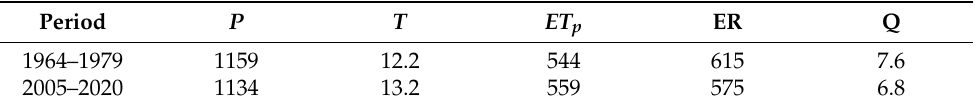
Table 6. Table comparing the averages of the variables used for the analysis over the two study periods (1964–1979; 2005–2020): P = precipitation (mm); T = temperature ( ◦ C); ET p = evapotranspiration (mm); ER = effective rainfall (mm); Q = streamflow (m 3